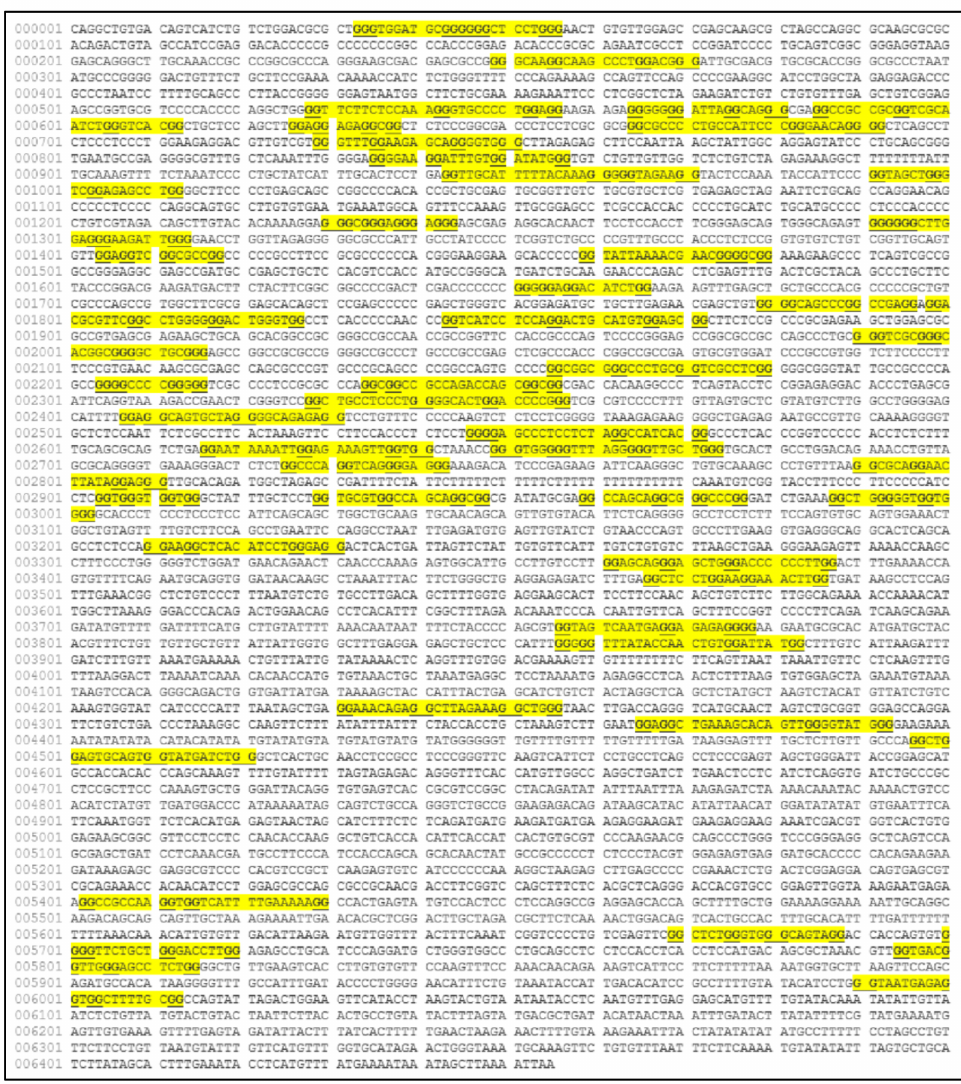
Figure 5. The predicted G-quadraplex sequences on the MYCN nucleotide sequence (image